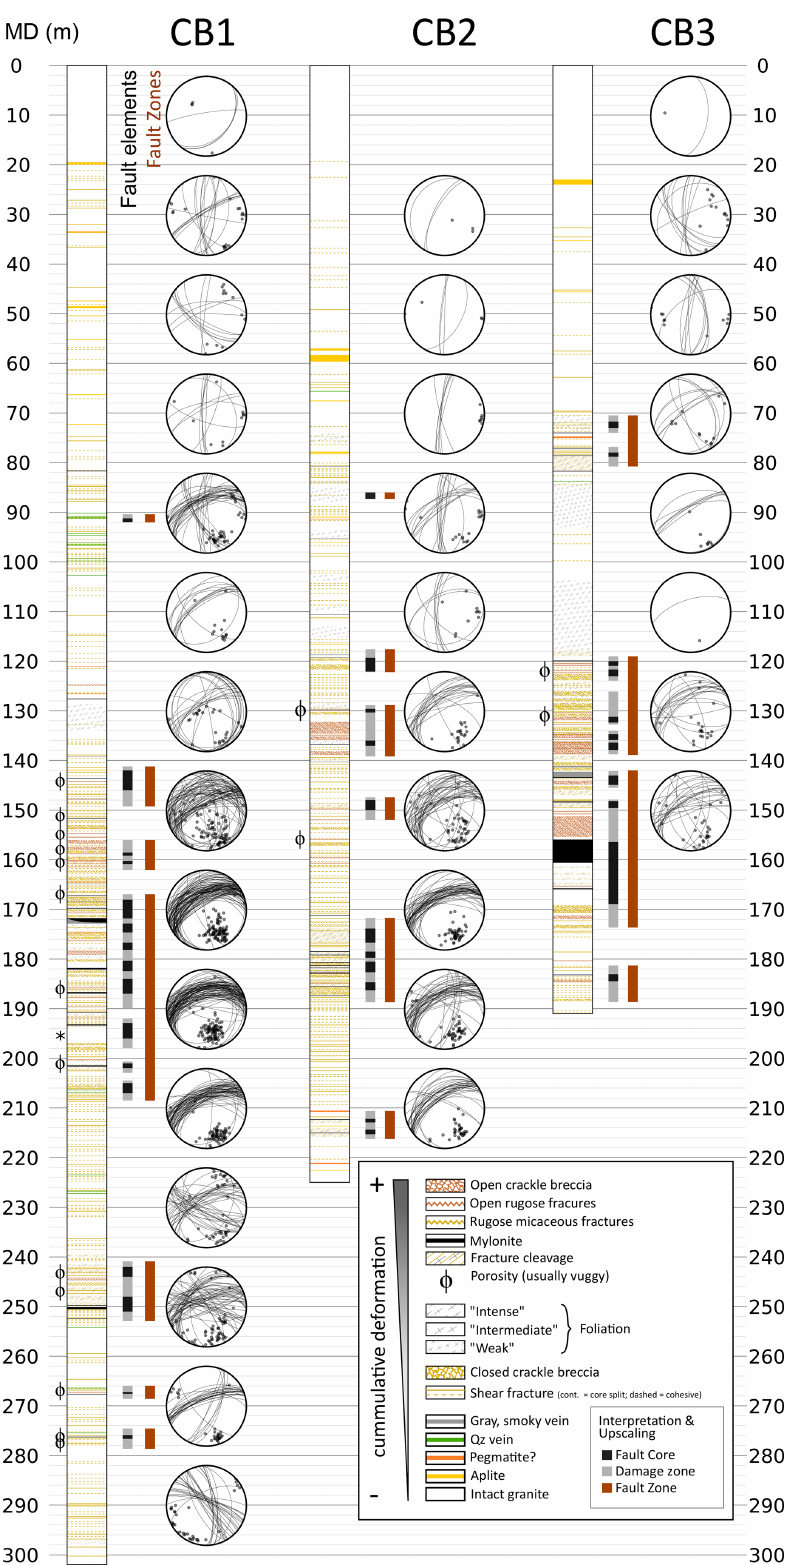
Figure 5. Core description showing the geological designations and structural orientations (measured by the acoustic and optical televiewers, i.e.,